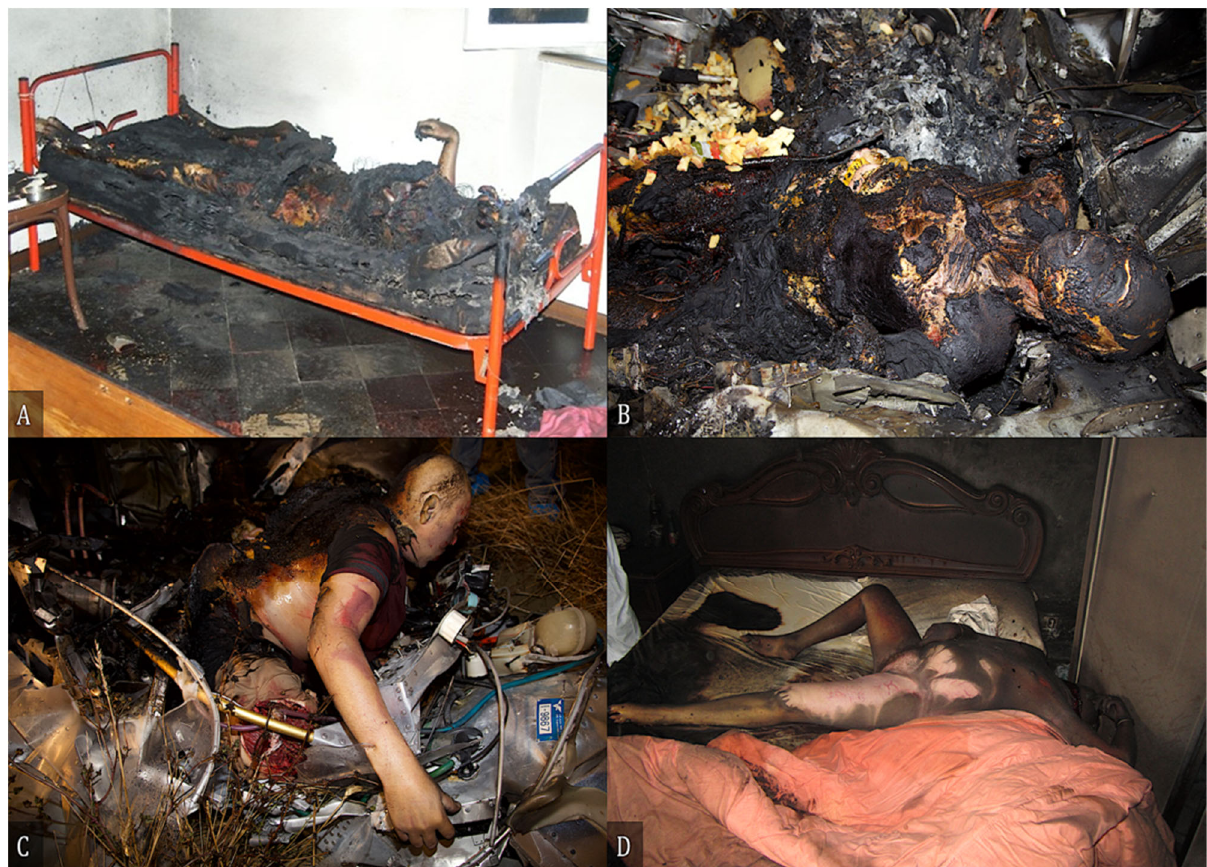
Figure 5. ( A ) Body of a male subject found in an apartment of a building where the fire department had extinguished a fire, in one of the bedrooms. The apartment had been spared the effects of the flames, which had only affected the bed on which the man was lying. ( B ) Body found in the left side of the cockpit of an ultralight aircraft, with the feet stuck in the pedals and the torso stretched towards the rear of the cockpit; the body was almost completely charred and lacked features useful for direct recognition. ( C ) Partially charred body with the lower limbs stuck in the pedals of the aircraft and the torso partially protruding from the cockpit of an ultralight aircraft. ( D ) Body of a female found partially charred in the bedroom of her